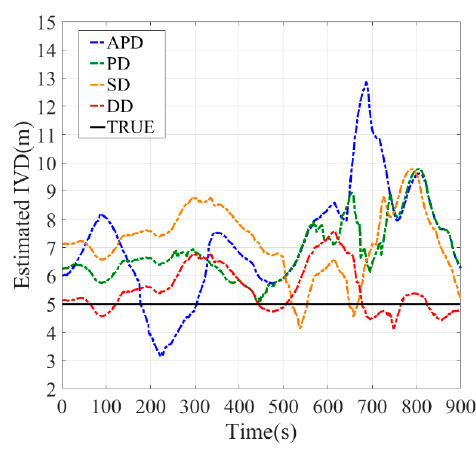
Figure 10. Baseline = 5 m.